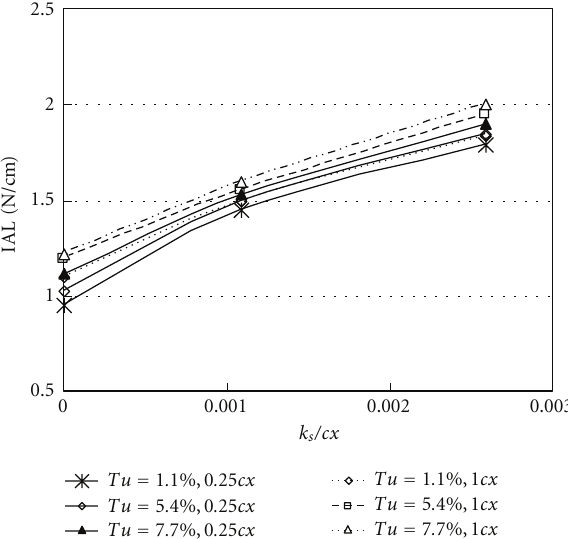
Figure 17: Comparison of dimensional integrated aerodynamic loss as dependent upon the normalized equivalent sandgrain roughness size for Tu = 1.1–1.6 percent for a cambered vane [38]. Figure 18: Comparison of dimensional integrated aerodynamic loss as dependent on normalized equivalent sand grain roughness size for di ff erent inlet turbulence intensity levels, at two di ff erent locations downstream of the test vane trailing edge, for a smooth, cambered vane with M ex = 0 . 71